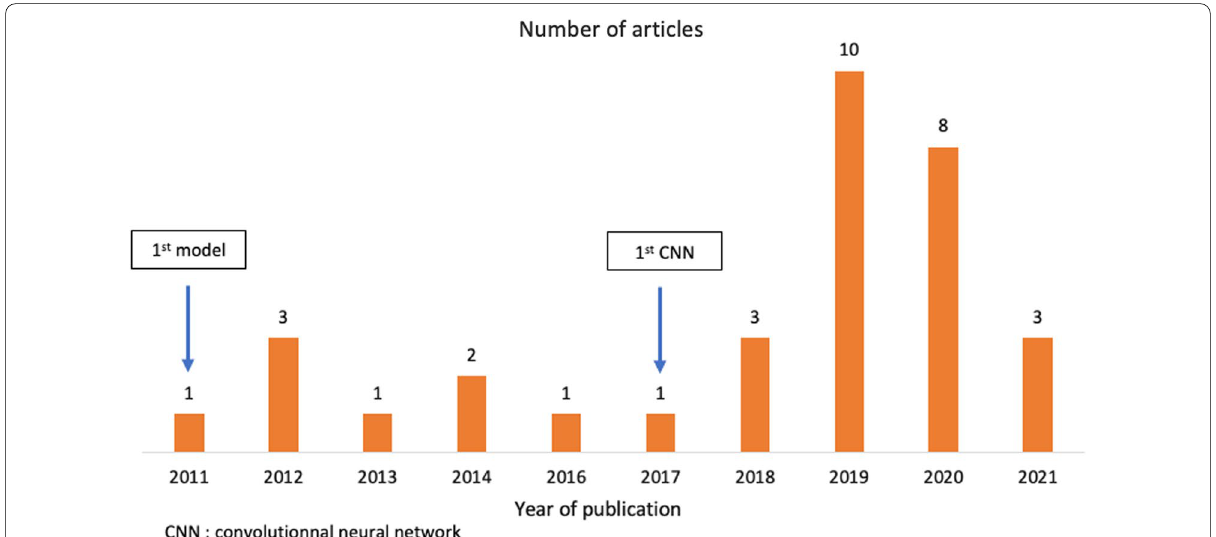
Fig. 2 Chronological distribution of the 33 reviewed articles. 1st model for prostate zonal anatomy segmentation was published in 2011. 1st convolutional neural network (CNN) was published in